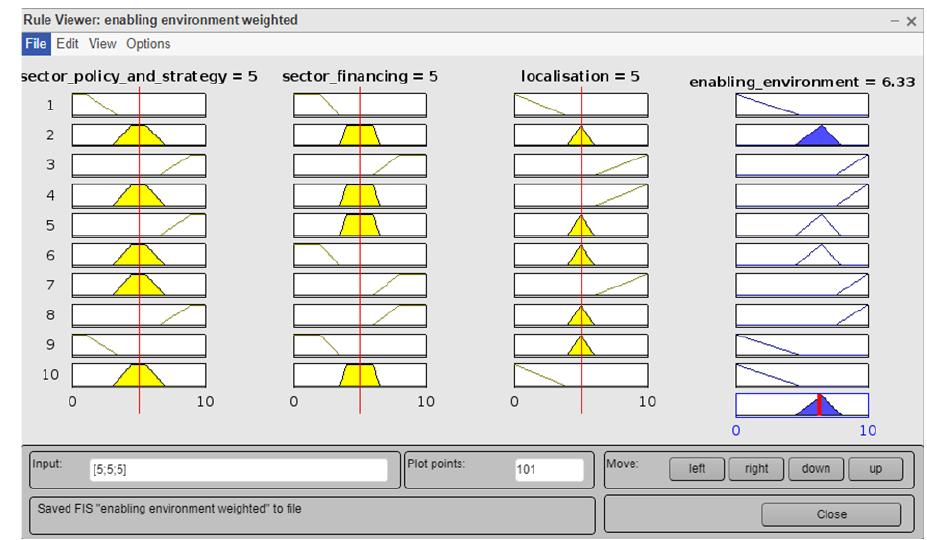
Figure 7. Rule set for the enabling environment analysis applied to ESAR country. Based on the respective models and fuzzy logic analysis results, countries were then classified as either weak, fairly strong, or strong for the enabling environment factor and as limited, fair, or good for the data for monitoring SDG6 factor. The model results and classification assigned for the enabling environment are summarised in Table 3 below Table 3. Fuzzy model results for enabling environment — ESAR countries. Fuzzy Model Enabling Environ- Country Results ment Classification